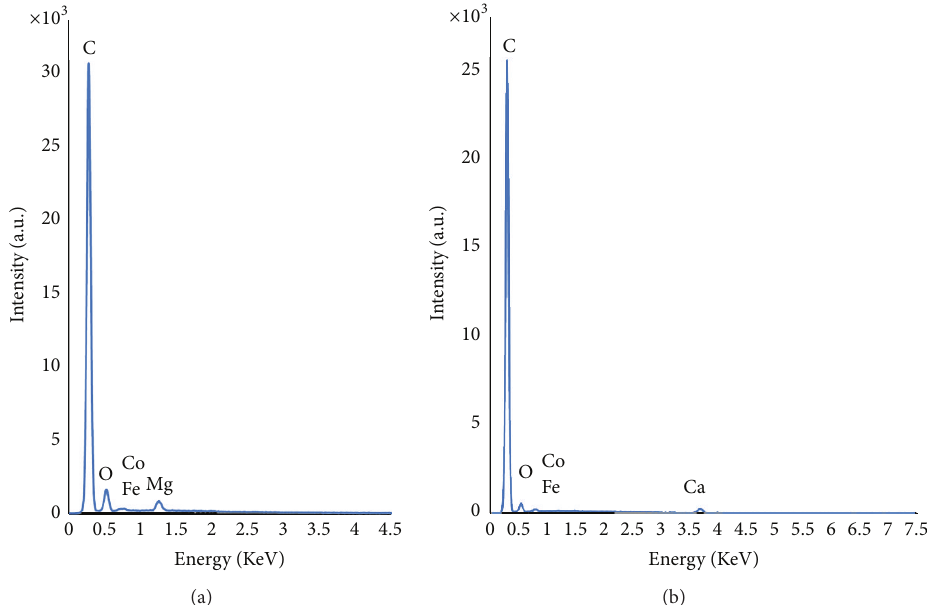
Figure 4: Energy dispersive spectroscopy (EDS) of nanomaterial synthesized from (a) Fe/Co supported on magnesium oxide and (b) Fe/Co supported on calcium carbonate.